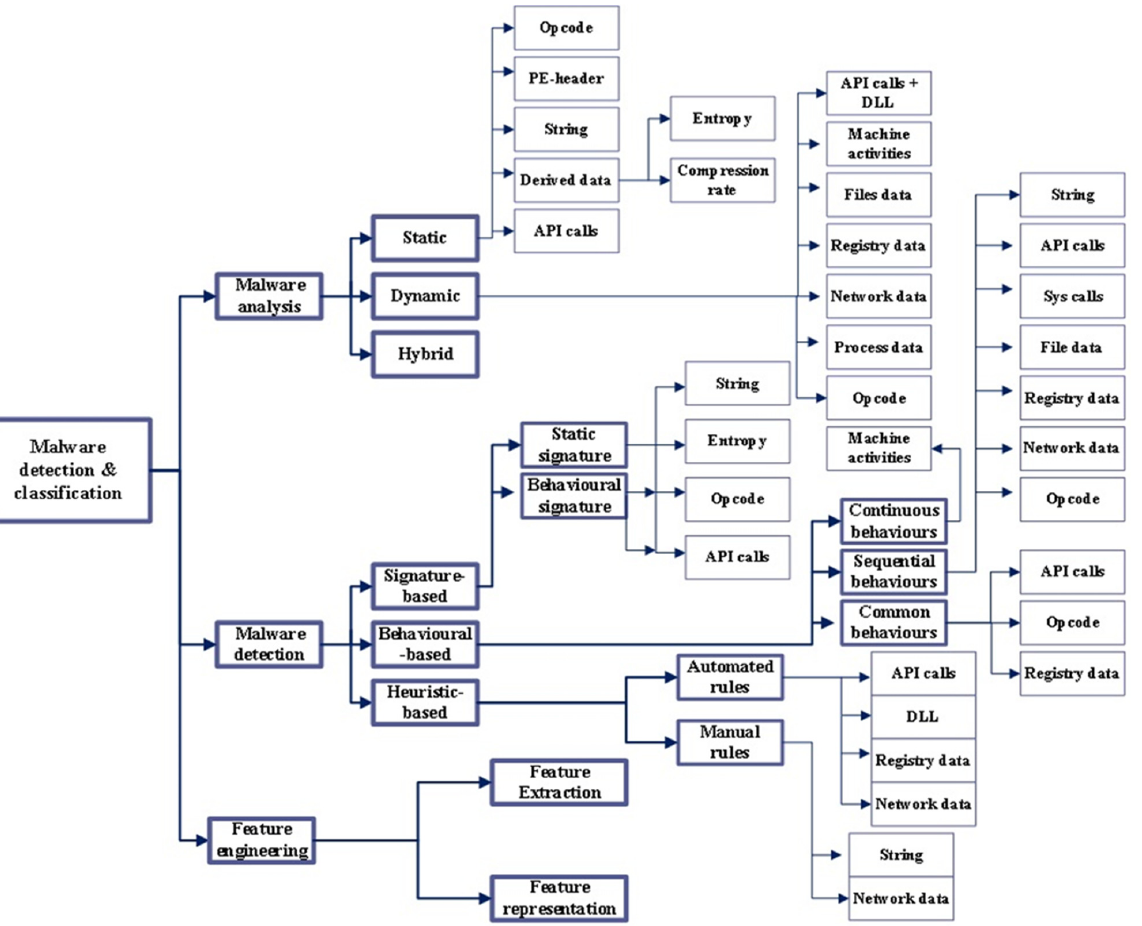
Figure 3. Malware Analysis and Detection